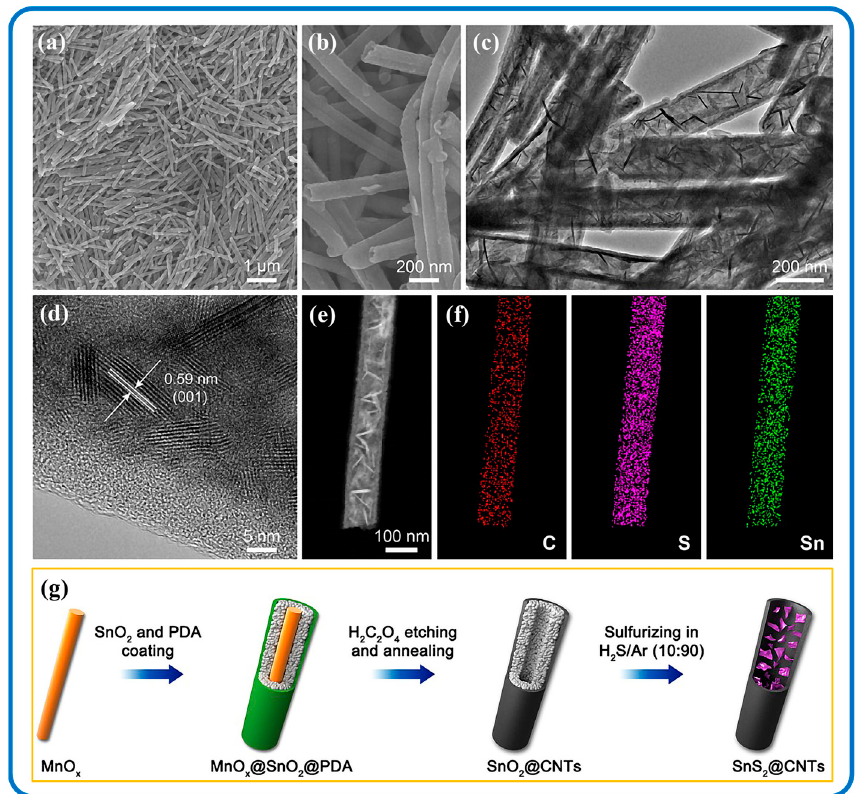
Figure 8. (Characterization of SnS 2 @CNTs in terms of morphology and structure, ( a , b ) FE-SEM images, ( c ) TEM image, ( d ) HRTEM image showing SnS 2 nanosheet with evident lattice fringe space of 0.59 nm, ( e ) High-angle annular dark-field scanning transmission electron microscope (HAADF-STEM) image of one individual SnS 2 @C nanotube, and ( f ) elemental mapping of SnS 2 @C nanotube, corresponding to C, S, and Sn elements. ( g ) Synthesis of SnS 2 @CNTs depicted schematically. Reproduced with permission from [136]. Copyright 2018, Elsevier.